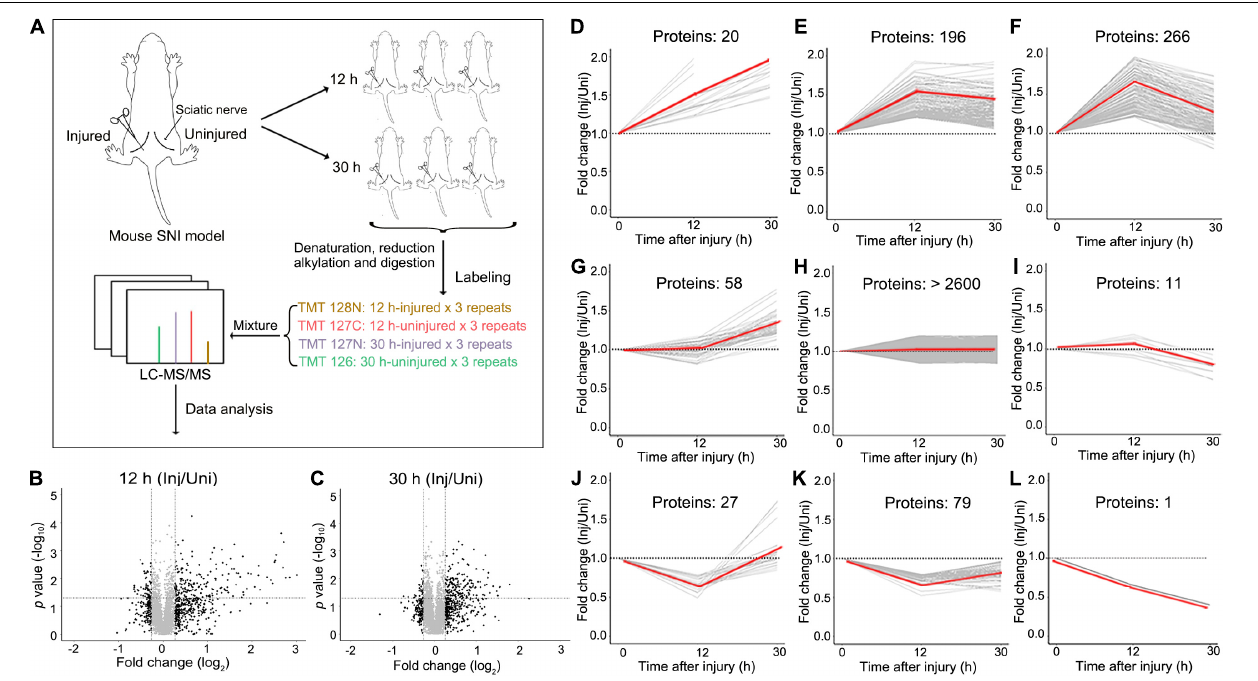
FIGURE 1 | The experimental design and overview of the data of the quantitative proteomic analysis of mouse SNI. (A) The model of mouse SNI and the experimental design for the LC-MS/MS analysis. The left sciatic nerve of the mouse was injured, and the right sciatic nerve of the same mouse received sham surgery and was used as an internal control. Both injured and uninjured nerve samples were collected at 12 h or 30 h after injury for the subsequent LC-MS/MS analysis. For each time point, 3 mice were examined. (B,C) The scatter plots showing the proteins detected by the LC-MS/MS analysis at 12 h (B) or 30 h (C) after SNI. The fold change (injured/uninjured) and the statistical p -value of each protein detected are shown. Inj, injured; Uni, uninjured. (D–L) Different patterns of protein changes in the injured mouse sciatic nerve over time. 20 proteins are continuously increased at 12 and 30 h (D) ; 196 proteins are increased at 12 h and then unchanged at 30 h (E) ; 266 proteins are increased at 12 h and then decreased at 30 h (F) ; 58 proteins are unchanged at 12 h but then increased at 30 h (G) ; over 2600 proteins are unchanged at either time point (H) ; 11 proteins are unchanged at 12 h but then decreased at 30 h (I) ; 27 proteins are decreased first at 12 h and then increased at 30 h (J) ; 79 proteins are decreased at 12 h and then unchanged at 30 h (K) ; 1 protein kept decreasing at both 12 and 30 h after injury (L) . Of note, a theoretic value of 1 is set for the 0 h time point (injured/uninjured at 0 h), which serves as a baseline for the comparison of the proteomic changes at 12 and 30